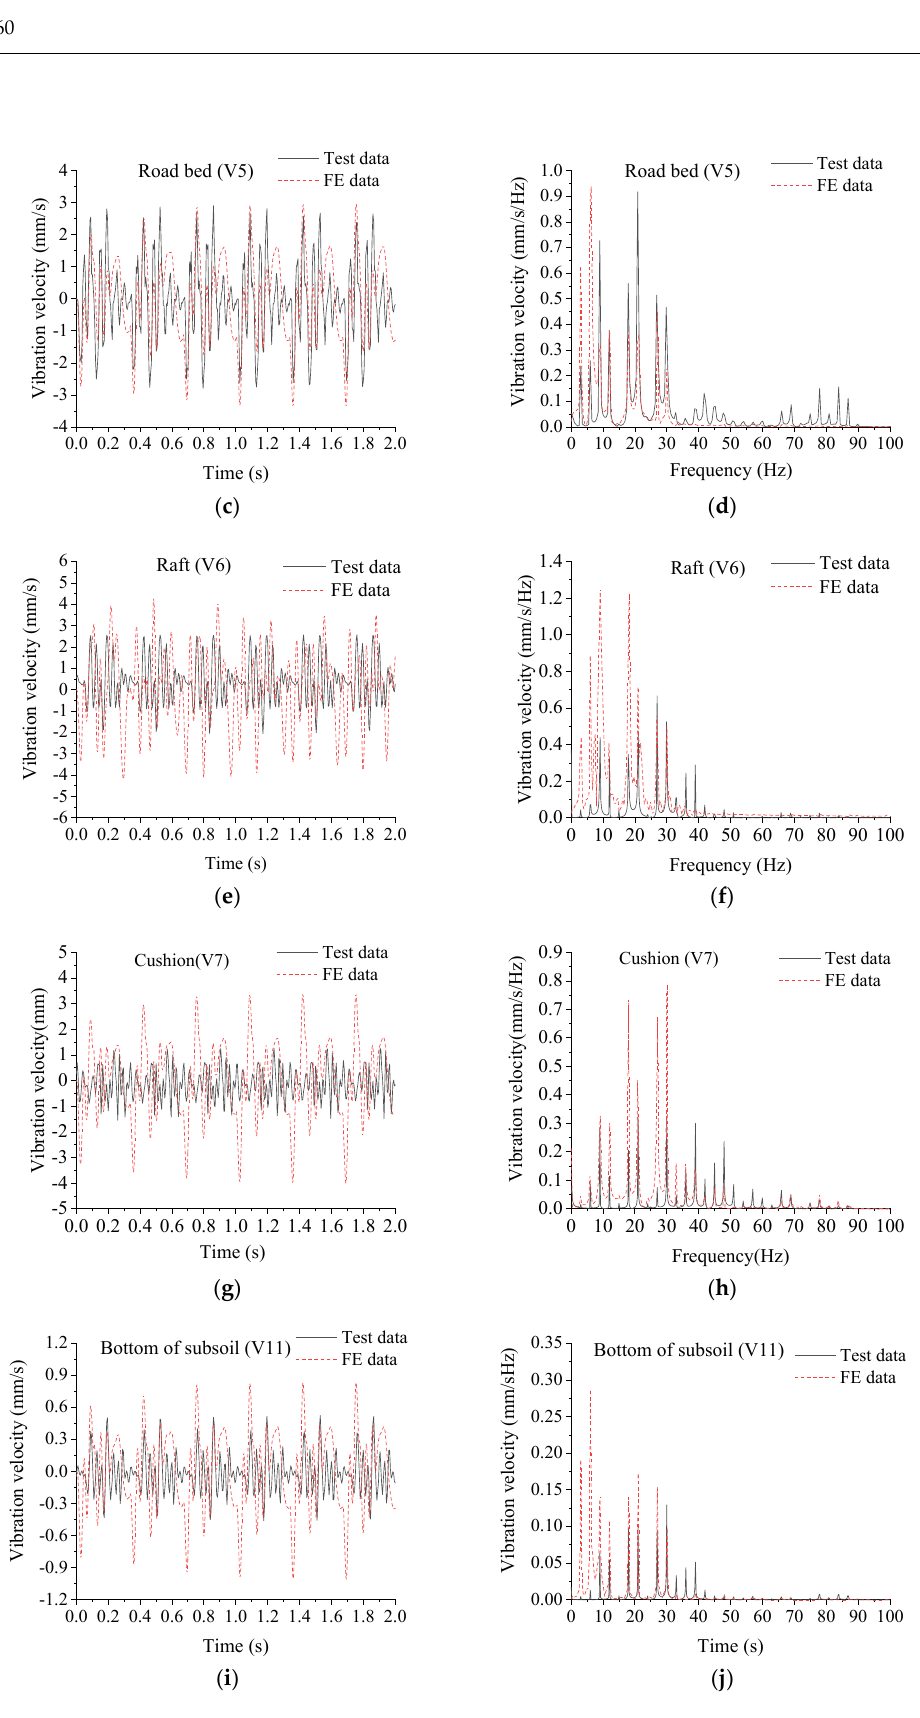
Figure 17. Comparisons of the vibration velocity between the FE and test results for train speed v = 270 km/h. ( a ) Track slab (V1, time domain), ( b ) Track slab (V1, frequency domain), ( c ) Roadbed (V5, time domain), ( d ) Roadbed (V5, frequency domain), ( e ) Raft (time domain), ( f ) Raft (frequency domain), ( g ) Cushion (time domain), ( h ) Cushion (frequency domain), ( i ) Bottom of subsoil (time domain), ( j ) Bottom of subsoil (frequency